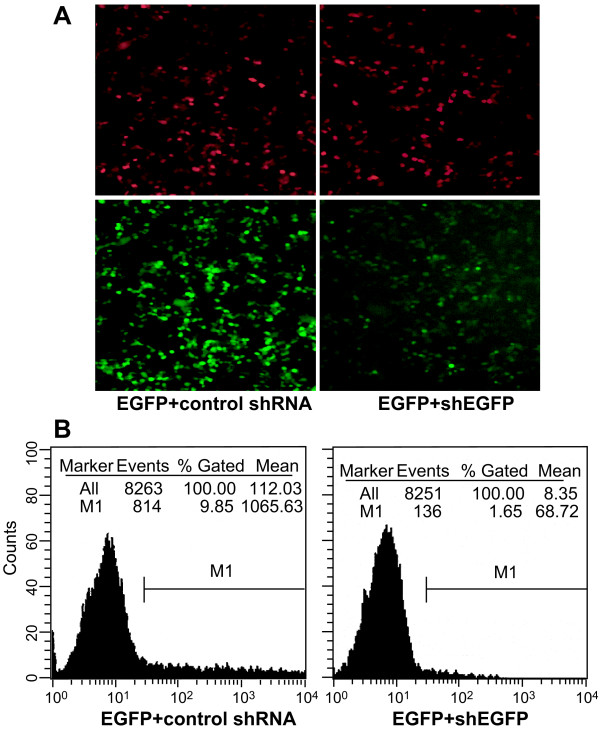
A. Suppression of EGFP expression by a "YIU" shRNA construct in mouse NIH3T3 cells. This shRNA cassette targets EGFP nt 243–261, GCACGACTTCTTCAAGTCC, selected as an effective shRNA cassette by a screen described in the text. When cotransfected with pEGFP vector at a molar ratio of 3 to 1 (shRNA:pEGFP), GFP fluorescence was suppressed; DsRed2-C1 was used as an internal control. Images were taken 24 h after transfection. B. Quantitative analysis of suppression efficiency by flow cytometry. The shRNA expression vector and the GFP reporter vector pMIG, at a molar ratio of 3 to 1, were cotransfected into mouse NIH3T3 cells. A "classic" shRNA expression construct targeting luciferase was similarly cotransfected in control cells. Assays were performed in triplicate at 48 h after transfection. The gate M1 was established using untransfected cells. The suppression, as measured by the decrease in mean fluorescence of the gated population, was quantified by flow cytometry in triplicate for each sample. Note that this is likely to provide a minimal measure of suppression, as GFP expression of many transfected cells may no longer fall within the gate; in fact, the gated population is markedly decreased in cells cotransfected with the shRNA construct targeting EGFP.